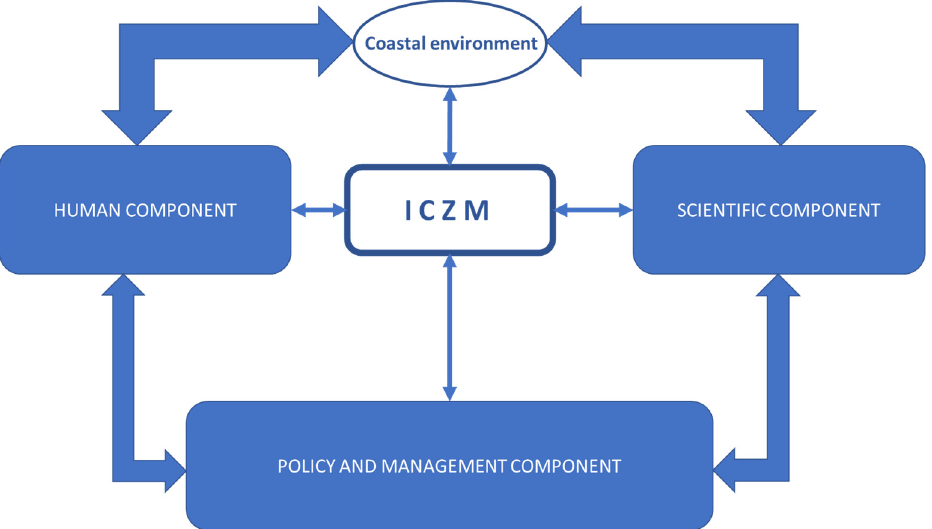
Figure 1. Diagram of the integrated coastal zone management process. Source: author after Rutger de Graaf-van Dinther (editor), Climate-Resilient Urban Areas’ Governance, Design, and Development in Coastal Delta Cities.